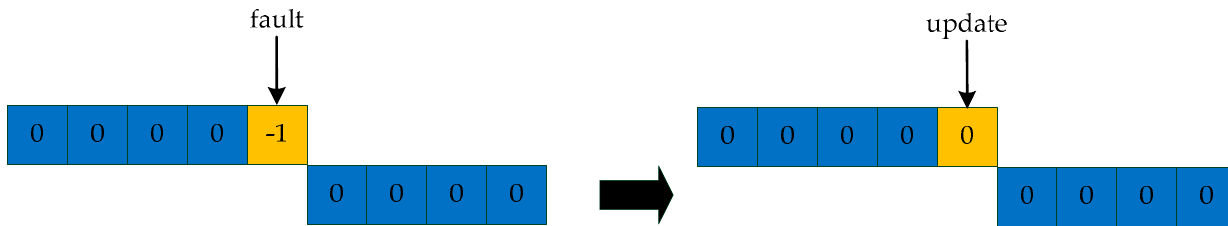
Figure 14. Eliminate faults in lines. The fault is caused by noise and algorithm error, and we update the slope of the current point using the slope of the point ’ s nearest neighbor.